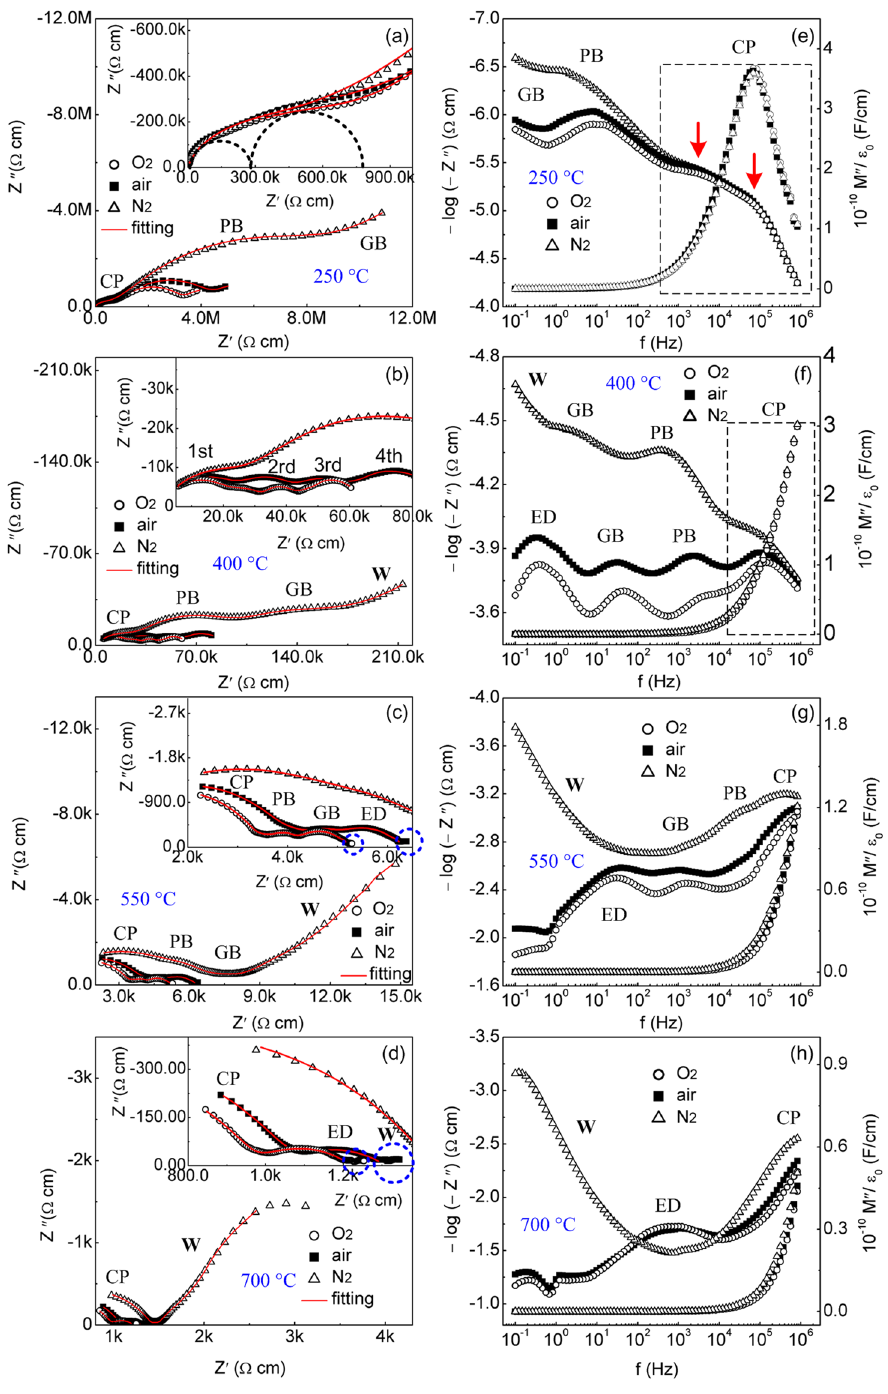
Figure 4. ( a – d ) 250–700 °C complex Z * plots of the air-, O 2 - and N 2 -processed BiT-Bi samples, and insets showing regionally enlarged drawings (the symbols: experimental data; the solid lines: fitting spectra). ( e – h ) 250–700 °C Z ″ / M ″ plots of air-, O 2 - and N 2 -processed BiT-Bi samples. “CP” crystalline plate, “PB” plate boundary, “GB” grain boundary, “ED” electrode impedance, “W” Warburg